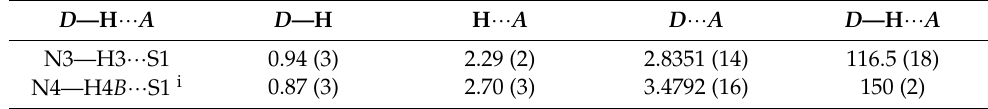
Table 7. Hydrogen-bond geometry (Å, ◦ ) for compound 5 .